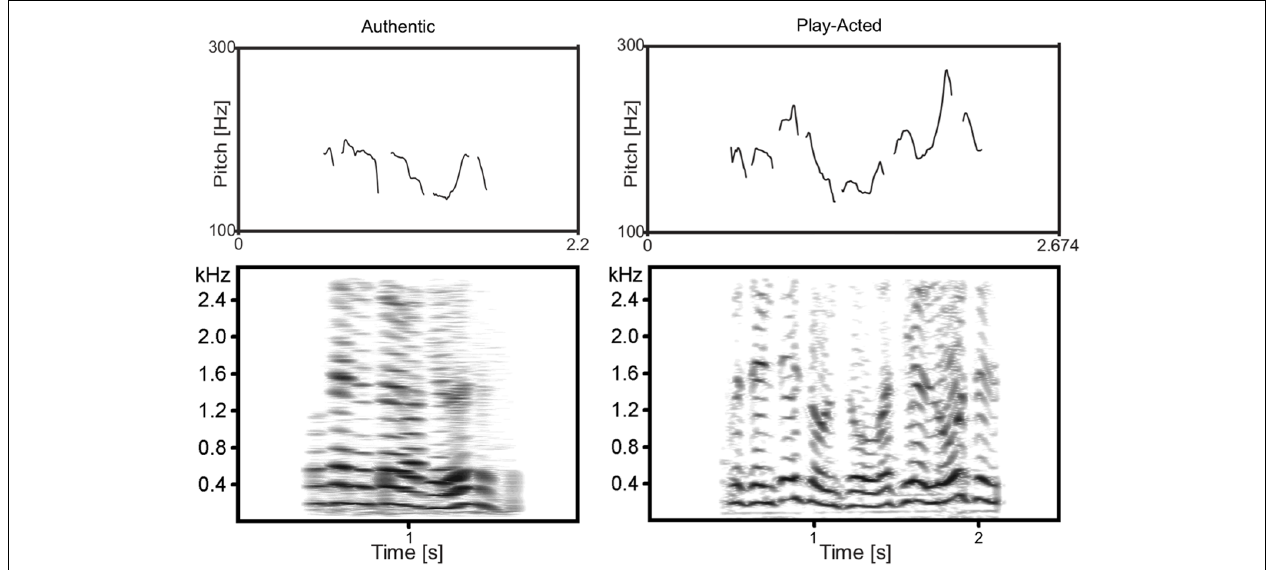
FIGURE 1 | F0 contour (top) and spectrogram (bottom) of two complementary example recordings. Examples are of the same text (“ ... Präsenz ist und so, was hier los ist ... ” translated: “ ... presence is and such, what is going on here ... ”) from the original authentic and play-acted